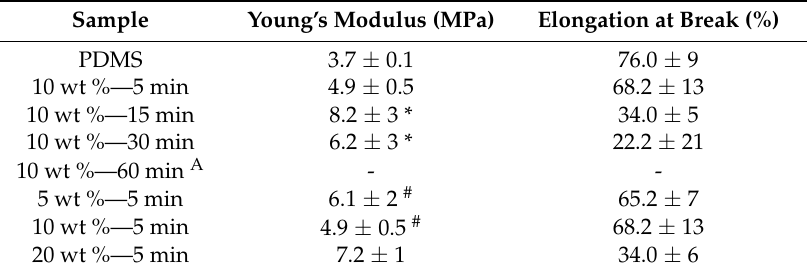
Table 1. Young’s modulus and elongation percentage values at the breaking point of uncoated and coated PDMS